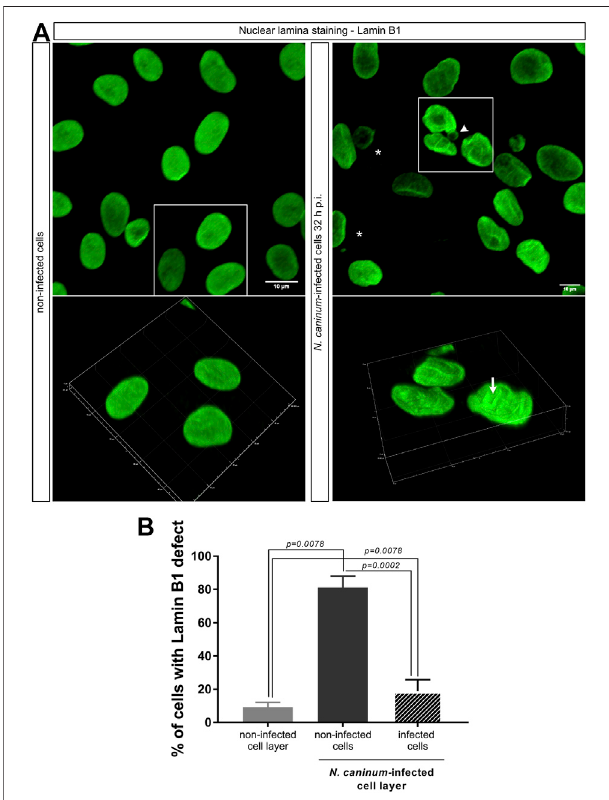
FIGURE 6 | Nuclear lamin B1 detection in N. caninum -infected BUVEC layers. (A) Nuclear lamina analysis by the staining of lamin B1 (green). Fixed cells were stained against lamin B1 for the nuclear lamina and DAPI for the nuclear area recognition (not shown in the image). A white arrowhead in the 3D volume projection image: circular structures protruding from the nucleus; asterisks: parasite localization; white arrow: lamin B1 folding. (B) Quanti fi cation of the percentage of host cells with distorted lamin B1 localization in the total N. caninum- infected BUVEC monolayer (dark and lightgray).Thescalebarrepresents10 µm.Barsrepresentthemedian±SDof three biological replicates.